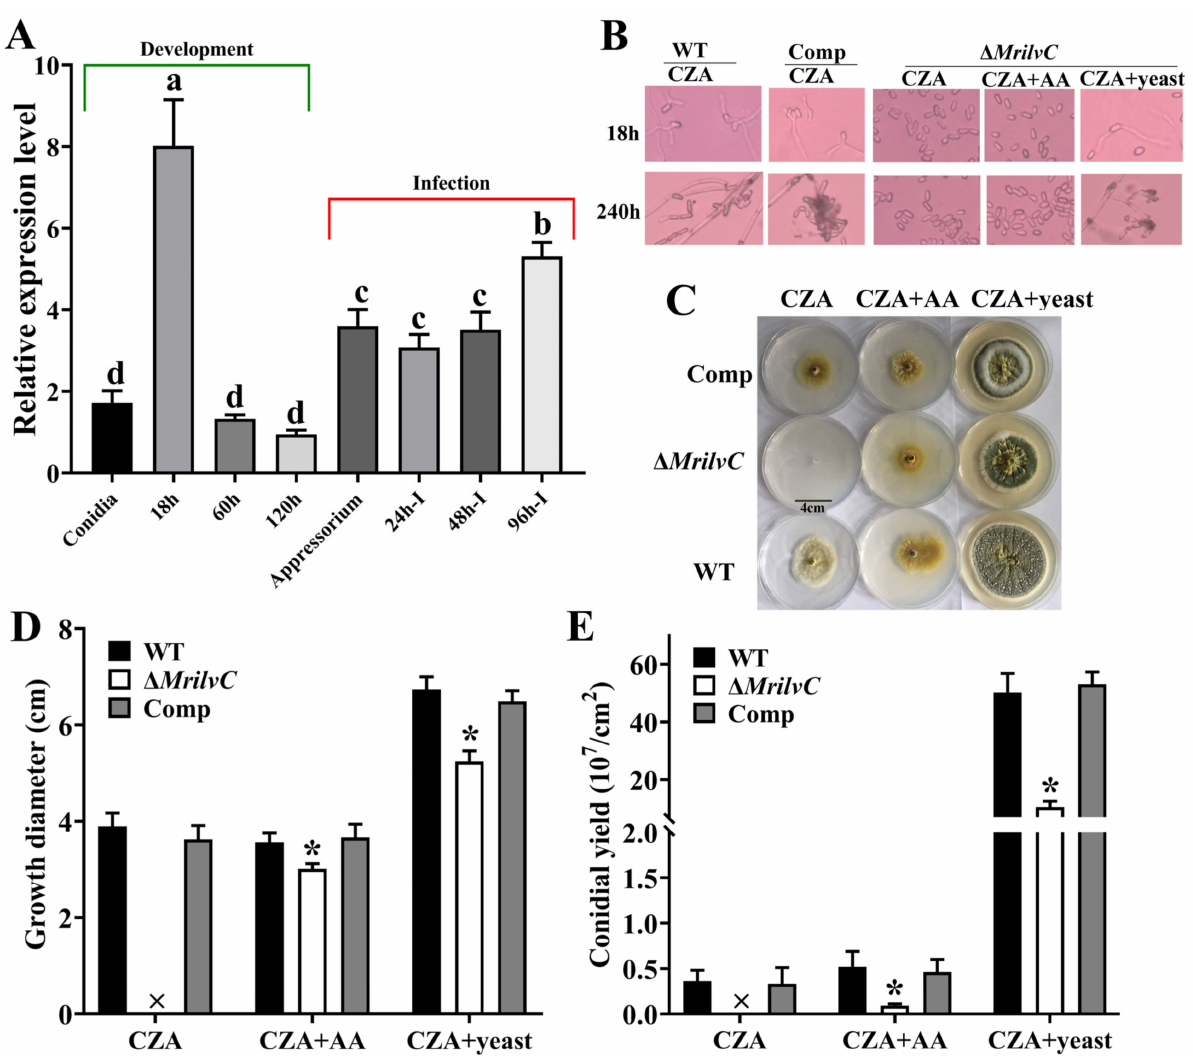
Figure 4. Deletion of MrILVC affected conidial germination, hyphal growth, and conidiation. ( A ) Transcriptional profiling of MrilvC at different developmental and infection stages. ( B ) Microscopy observation of WT and ∆ MrilvC in different media. ( C ) Colony morphologies of WT and ∆ MrilvC in different media. ( D , E ) Growth diameters and conidial yields of different strains cultured on CZA, CZA + AA, and CZA + yeast. Error bars represent the SEM of six replicate assays. * Significantly different expression ( p < 0.05). Different lowercase letters marked on the bars in each graph denote significant differences ( p <